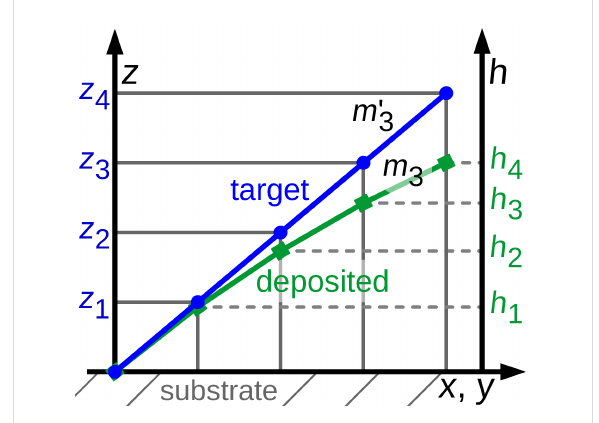
Figure 3: Visualization of the height-dependent deposition rate: The blue circles correspond to vertices defined in the geometry file with the desired height z 3D, i . The green squares represent data taken from a deposited structure via its SEM picture with the measured height h i . stands for the desired slope of a given edge, m i for the slope at a given position of the actual deposit. The higher a deposited edge becomes, the lower gets the actual deposition rate (with fixed parameters) due to a lower precursor replenishment by diffusion from the substrate.